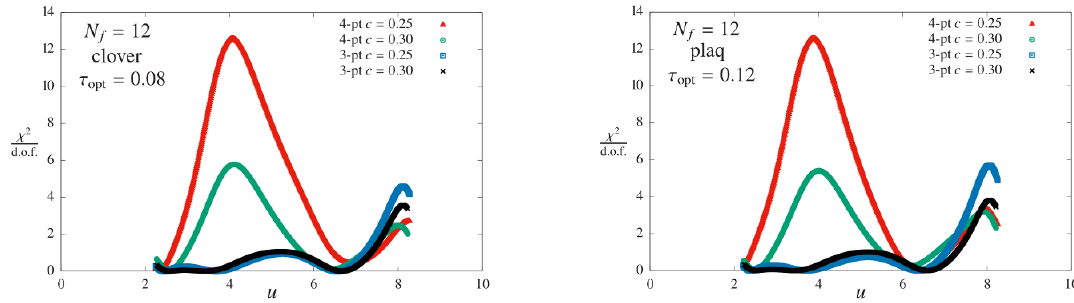
Figure 3 . (cid:31) 2 = d.o.f. from linear ( a=L ) 2 ! 0 extrapolations of the s = 3 = 2 discrete (cid:12) function vs. the renormalized coupling u . For each of the clover (left, with (cid:28) opt = 0 : 08) and plaquette (right, with (cid:28) (plaq) = 0 : 12) discretizations of the energy density E ( t ) in eq. (2.3) we compare three-point opt extrapolations using L (cid:21) 16 against four-point extrapolations using L (cid:21) 12, for both c = 0 : 25 and 0.3. While the larger c improves the quality of the extrapolations as expected [92], for most u the dominant contribution to the (cid:31) 2 comes from the L = 12 ! 18 point. Dropping L = 12 signi(cid:12)cantly improves the ( a=L ) 2 ! 0 extrapolations, except for u & 7. In this regime (cid:12)gure 2 shows that additionally dropping L = 16 would produce results for (cid:12) s farther below zero, reinforcing the existence of the IR (cid:12)xed